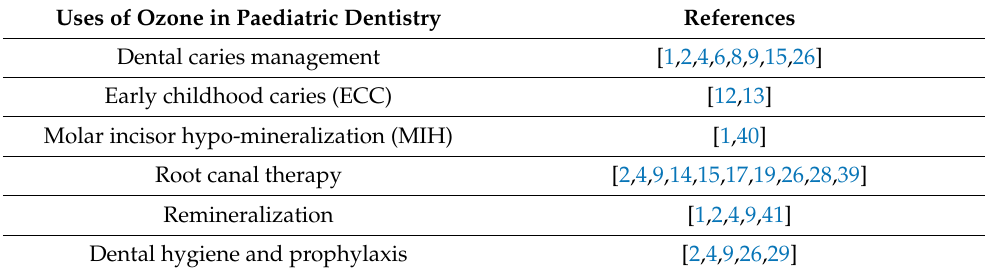
Table 1. Application of ozone therapy in paediatric dentistry and the main related references. Uses of Ozone in Paediatric